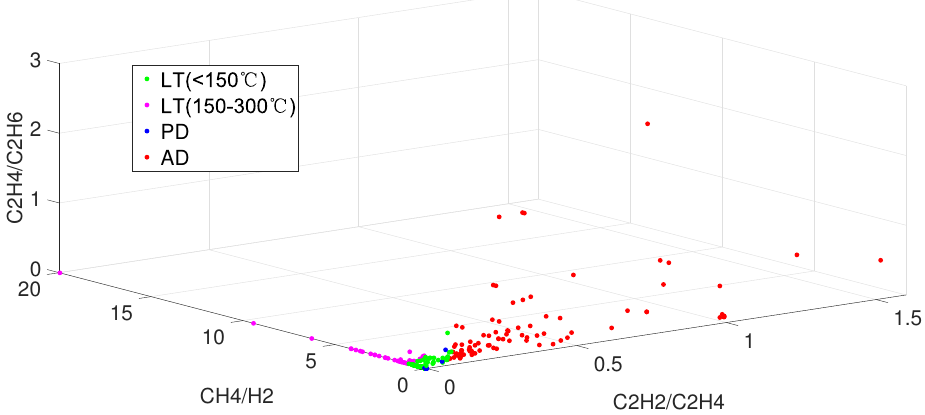
Figure 5. Distribution of fault characteristic data. Table 2. Some dissolved gas analysis data collected from actual